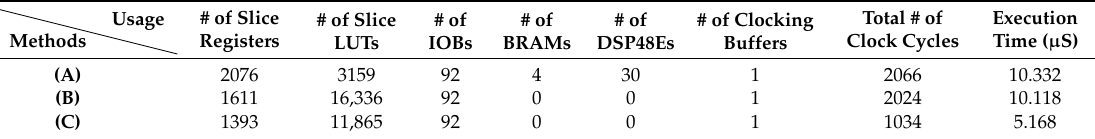
Table 3. The achieved hardware results of an FFT implementation with the different approaches.